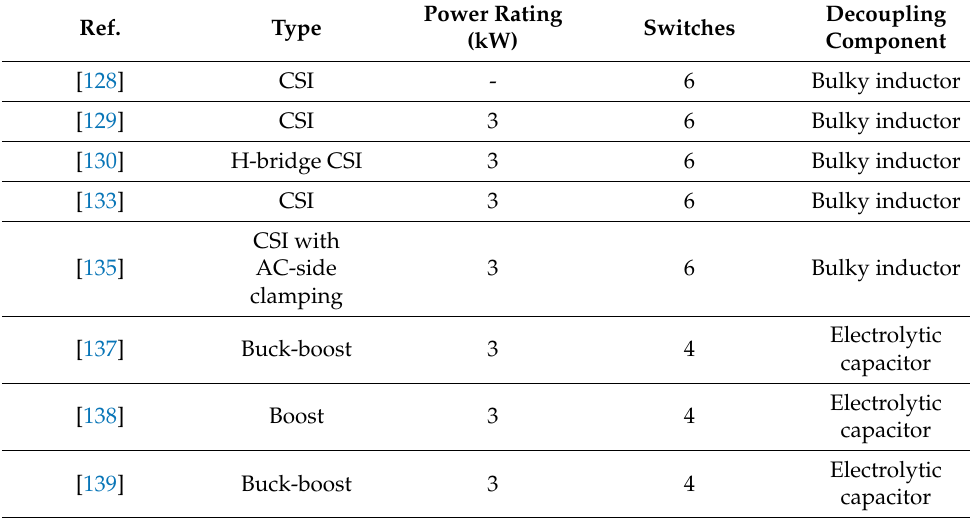
Table 10. Single-stage inverters for PV-connected applications.